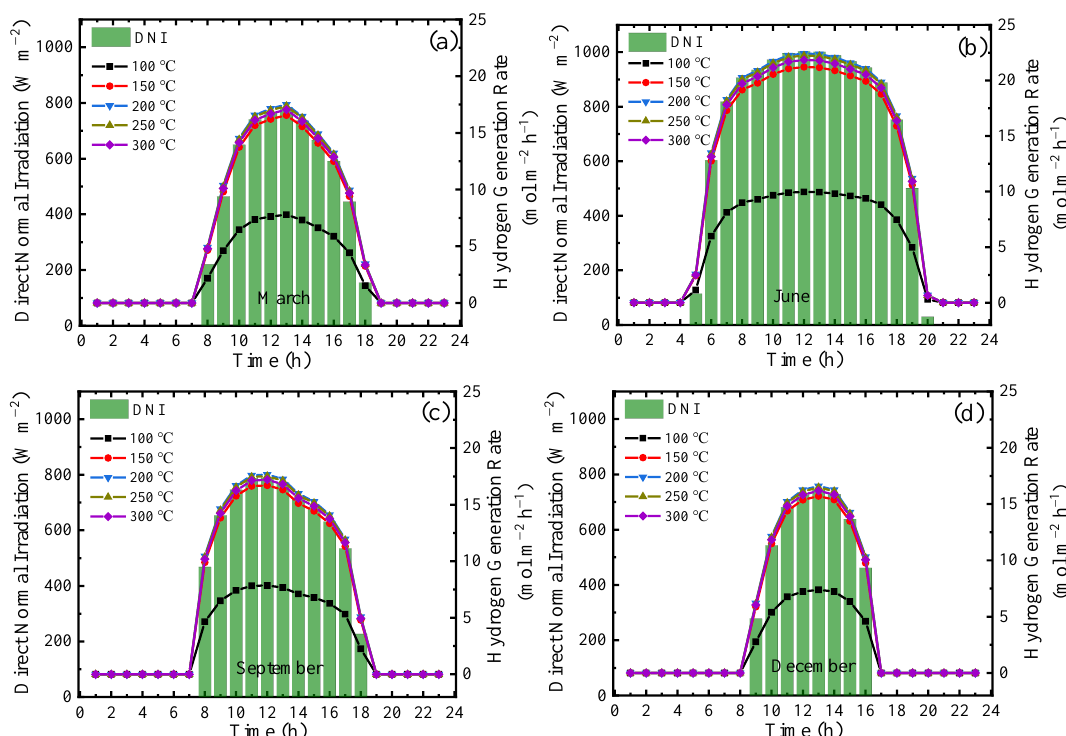
Figure 11. Variation in DNI and Y H2 on a typical sunny day of different months for different reaction temperatures at a permeate pressure of 0.2 bar with real separation energy ( η s → e = 15%): ( a ) March; ( b ) June; ( c ) September; and ( d ) December. Compared with temperature, the permeate pressure has a more significant effect on the generated Y H2 for each of the seasons. The results for generated Y H2 are shown in Fig- ure 12 for a reaction temperature of 150 °C with real separation energy and η s → e of 15%. The optimum permeate pressure for Y H2 is 0.25 bar, which produces a Y H2 of 21.9 mol×m − 2 ×h − 1 at noon in June. The results shown in Figures 10 and 11 exhibit the promising application of the solar-driven ESR system under realistic operating conditions.